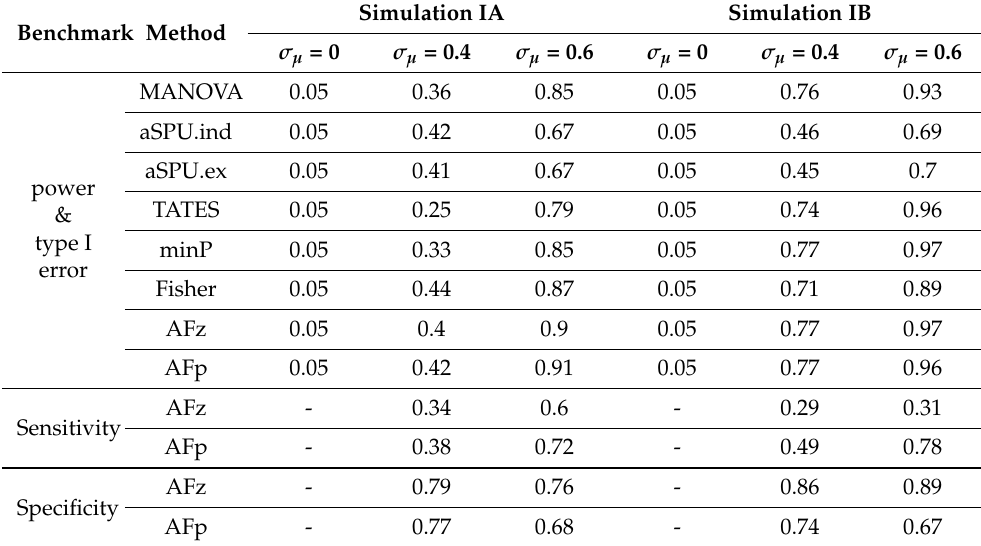
Table 1. Results of Simulations IA and IB when N 1 = 100. For σ µ = 0, the value indicates Type I error control, and for σ µ = 0.4 and 0.6, the value indicates power.